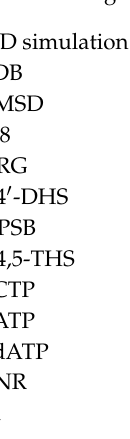
(I), Compound-1 (J), Compound-2 (K), and Compound-3 (L); Figure S41: Docking poses of S site on 5TUS and six ligands: Quercetin (M), Myricetin (N), Astringin (O), Miquelianin (P), Mulberroside A (Q), and Hydroxyurea (R); Figure S42: Docking poses of C site on 5TUS and six ligands: Cis-resveratrol (A), Piceatannol (B), M8 (C), 3,4,5-THS (D), 4,4 (cid:48) -DHS (E), and Pterostilbene (F); Figure S43: Docking poses of C site on 5TUS and six ligands: HPSB (G), DRG (H), Pinostilbene (I), Compound-1 (J), Compound-2 (K), and Compound-3 (L); Figure S44: Docking poses of C site on 5TUS and six ligands: Quercetin (M), Myricetin (N), Astringin (O), Miquelianin (P), Mulberroside A (Q), and Hydroxyurea